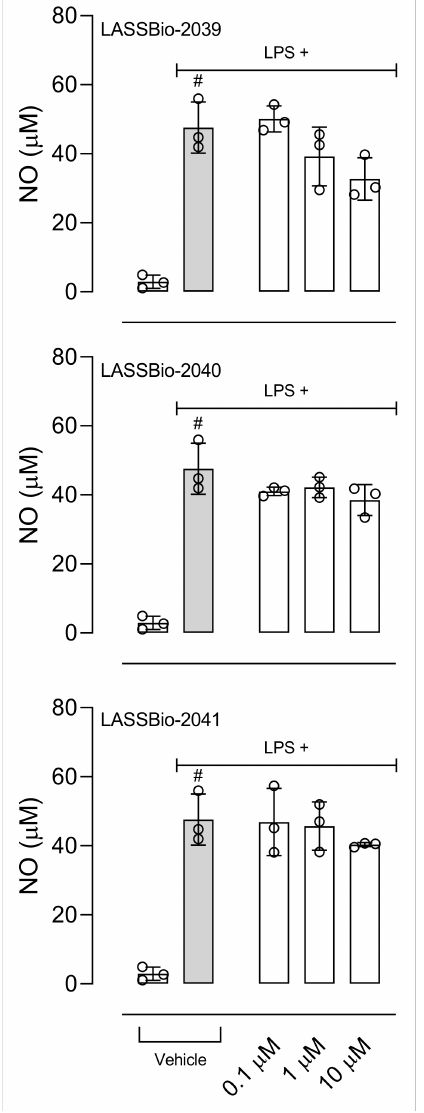
Figure 10. Effect of LASSBios in inducible nitric oxide synthase enzyme activity. J774.A1 cells were incubated with vehicle or lipopolysaccharide (LPS, 1 µ g/mL) and after 8 h received LASSBios at different concentrations (0.1, 1 or 10 µ M). Twenty-four hours after LPS activation NO accumulated in supernatant was measured. Results are expressed as media ± SD ( n = 3). Where no error bar is shown it is because it is smaller than the symbol. Statistical significance was calculated in GraphPad Prism 8.0 (San Diego, CA, USA) using analyses of variance (ANOVA) followed by Tukey post-test with p < 0.01 (#) when comparing LPS-activated cells treated with vehicle and non-activated cells treated with